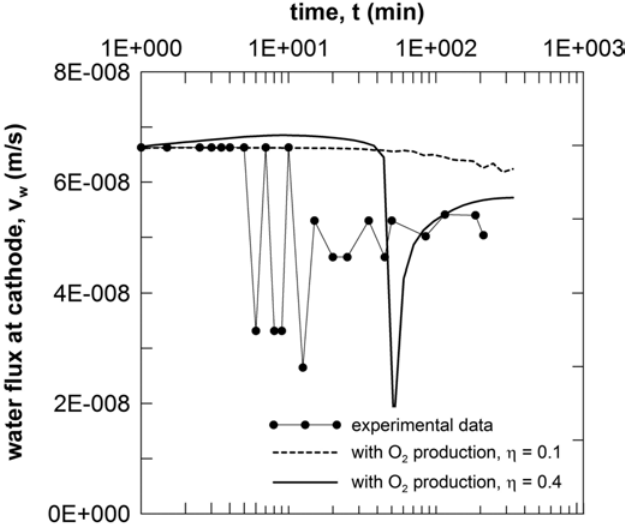
Fig. 7 – Electrokinetic filtration test: comparison between experimental data and numerical